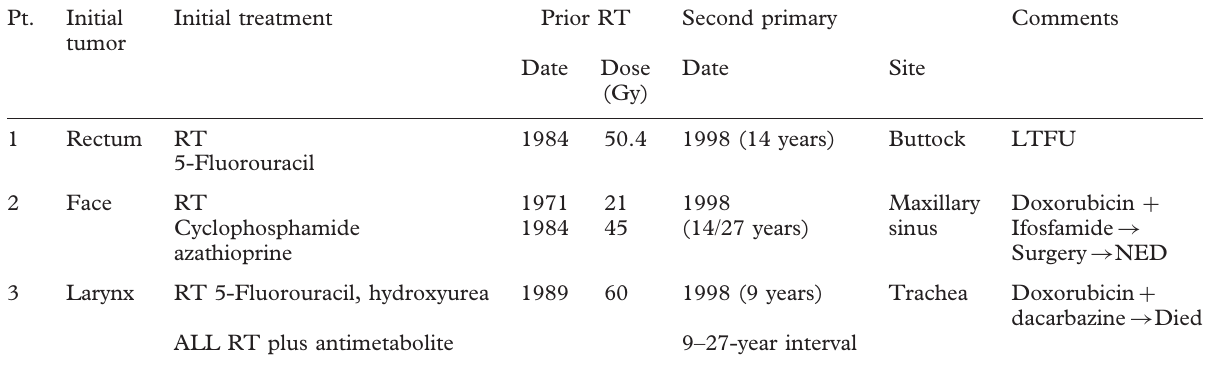
Table 1. Summary of